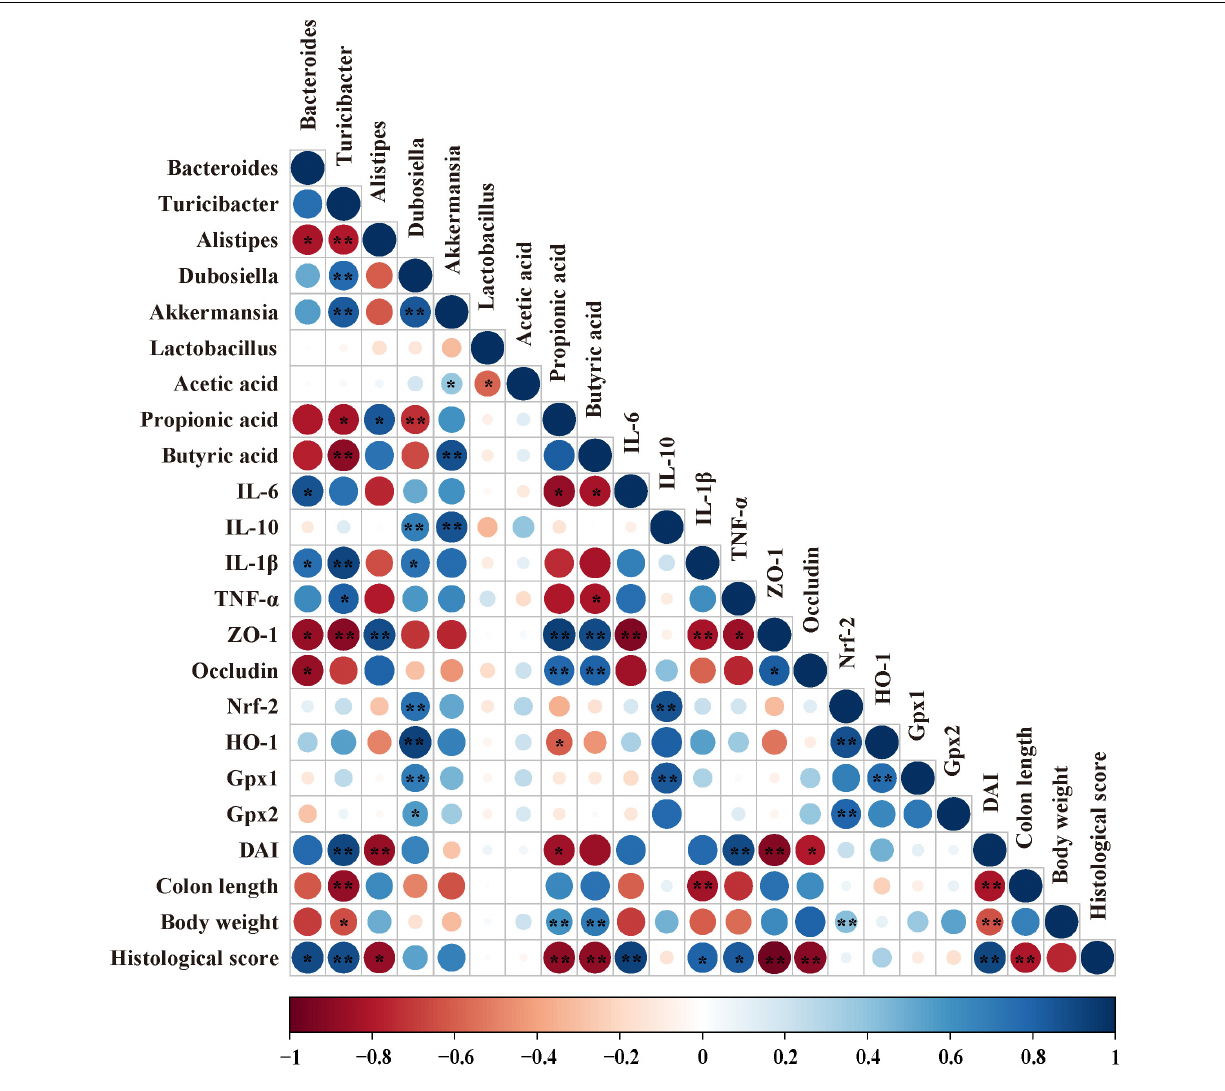
FIGURE 8 | Correlation analysis among biochemical indexes in DSS-induced colitis mice. The color of the circle represents positive or negative correlation, and the size of the circle represents the strength of the correlation. * p < 0.05, ** p < 0.01 (large circle = stronger